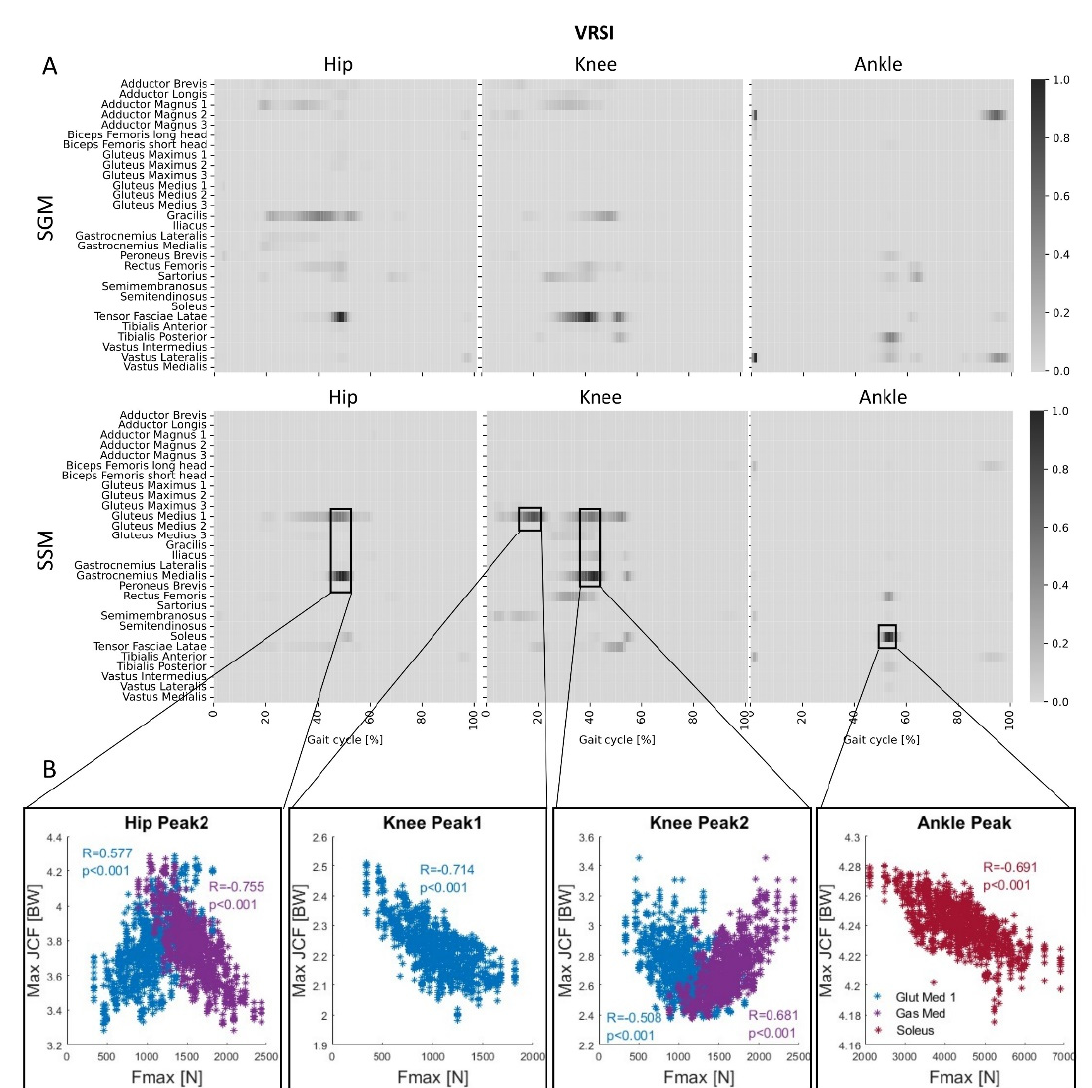
Figure 3. ( A ) VRSI heatmaps for JCFs of hip ( left column ), knee ( central column ) and ankle ( right column ). Results from generic model SGM are shown in top row, those from personalised SSM are in the bottom one. The x -axis represents the percentage of gait cycle, while the muscles are listed on the y -axis. Darker colours signify higher influence of the muscle on a specific time point. ( B ) Significant moderate (|R| > 0.5) or strong (|R| > 0.7) correlations between muscle F max and joint peak forces. For the hip and knees, Peak 1 refers to loading acceptance phase of gait and Peak 2 refers to push off phase, while ankle Peak corresponds to push off phase.